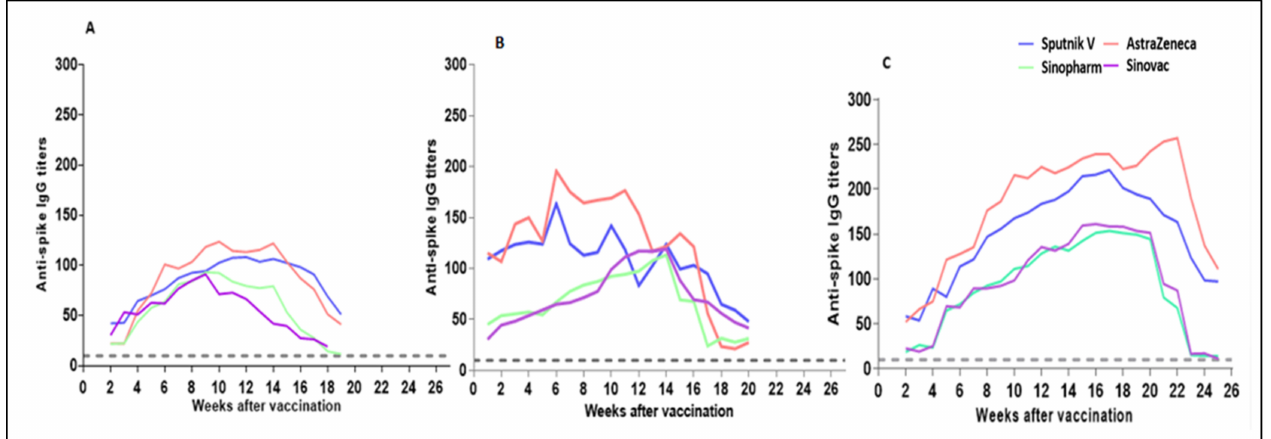
Figure 3. Individuals with previous SARS-COV-2 infection elicited faster and stronger antibody titers to all types of vaccinations than individuals with no previous infection (naïve). The charts shows waning dynamics in different groups according to previous infection status and vaccine dose. ( A ) Average anti-spike IgG titers after first vaccination dose in previously infected participants. ( B ) Average anti-spike IgG titers after first vaccination dose in seropositive participants who never had COVID-19 symptoms. ( C ) Trajectory of average of anti-spike IgG titers in fully vaccinated individuals (two doses). The grey dashed line in each graph indicates the threshold antibody positivity at 10